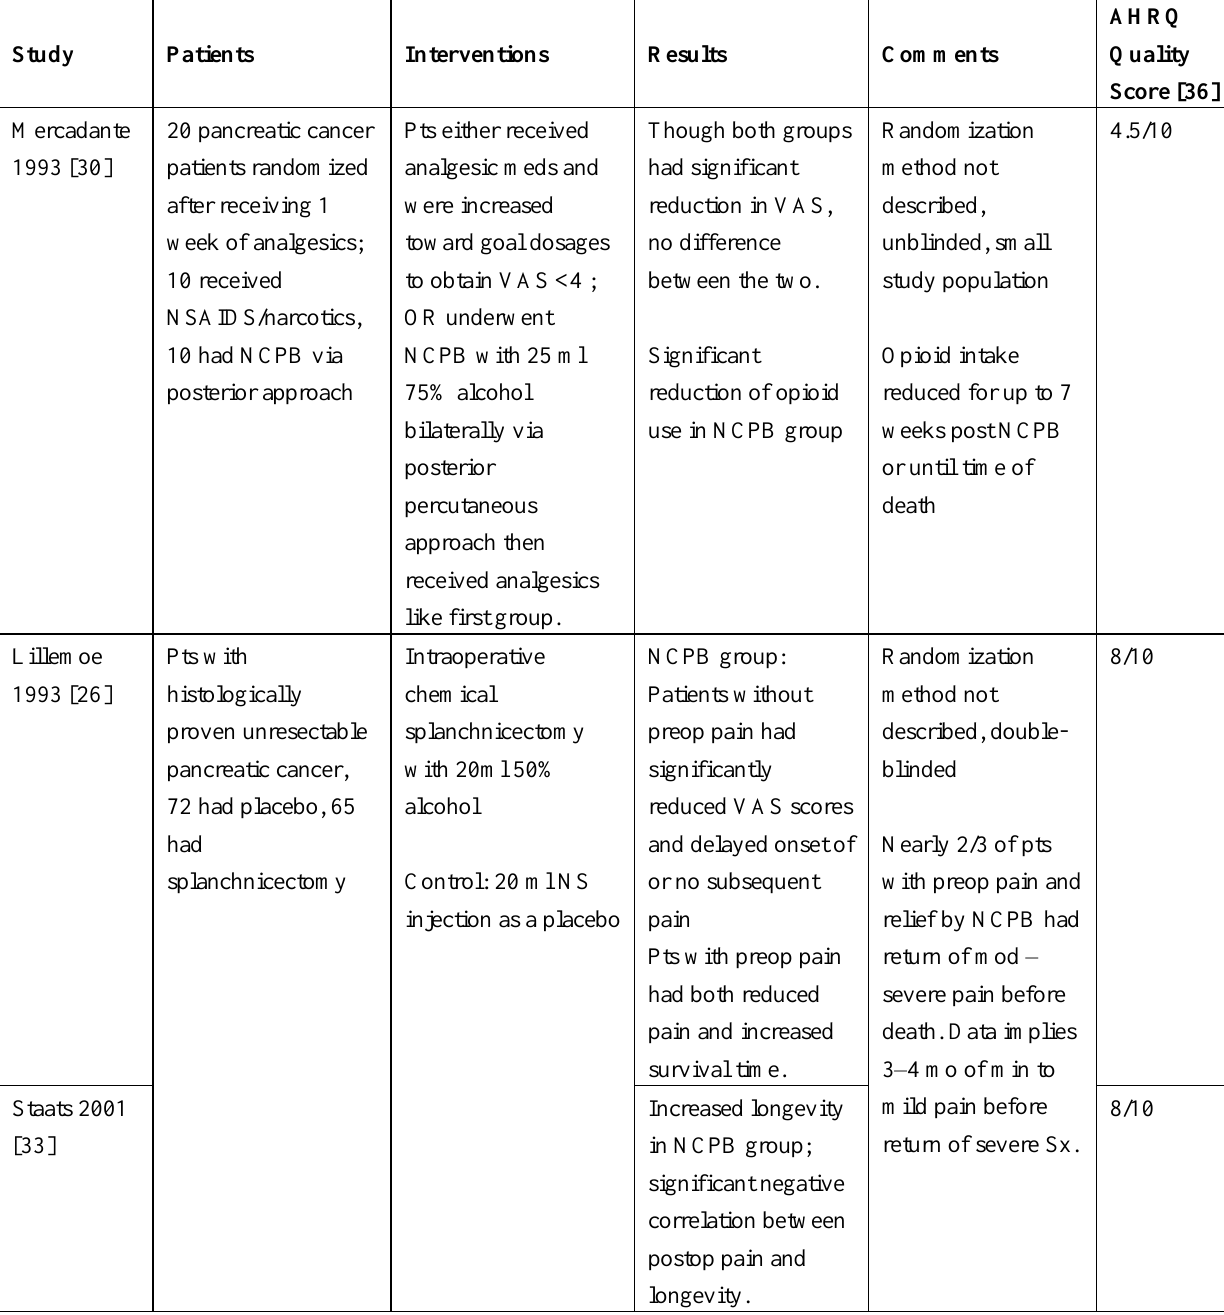
Table 3. Randomized Controlled Trials: Celiac Plexus Block in Pancreatic Cancer. Study